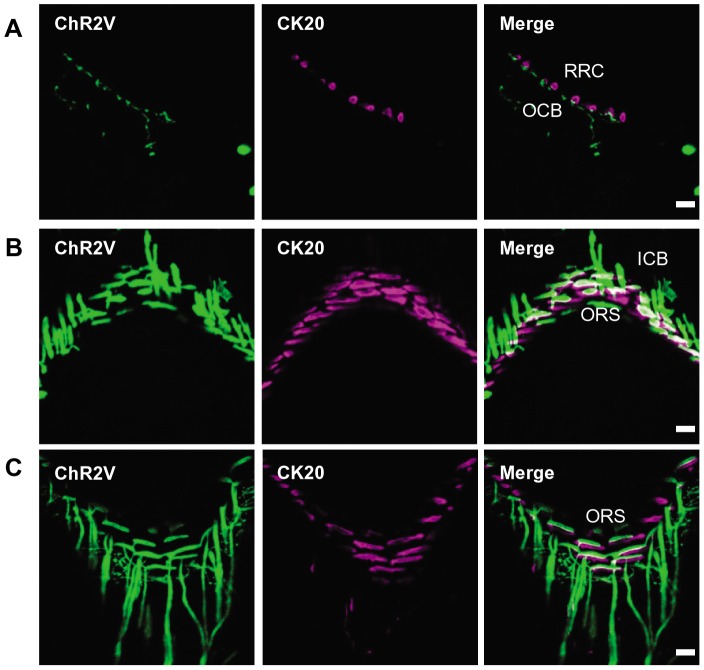
ChR2V-positive peripheral nerve endings around whisker follicles.
A, The ChR2V-immunoreactive nerve endings (green) at superficial layer around the whisker follicle where they were associated with CK20-positive Merkel cells (magenta). B, The ChR2V-positive nerve endings at middle layer. C, The ChR2V-positive nerve endings at deep layer. Abbreviations: RRC, rete ridge collar; OCB, ourter conical body; ICB, inner conical body; ORS, outer root sheath; MS, mesenchymal sheath. Scale bars indicate 20 μm.